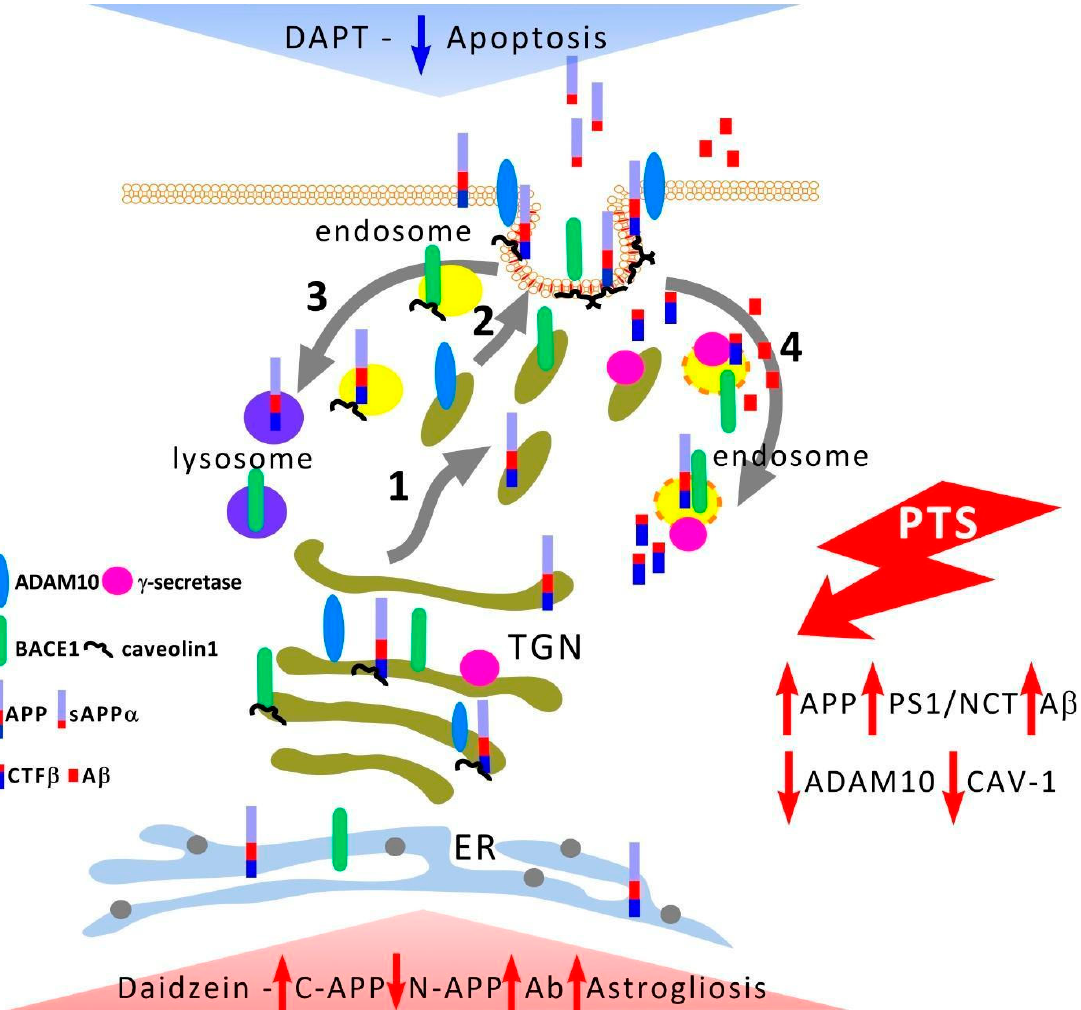
Figure 9. APP processing and effect of secretase and caveolin-1 inhibitors after PTS. Newly synthe- sized APP, BACE1, α -, and γ -secretases (1) are transported to the plasma membrane (2). Caveolae provide a platform for the regulation of APP processing. APP physically interacts with caveolin-1, providing its high concentration on the cytoplasmic membrane. APP is cleaved at the plasma mem- brane by α -secretase releasing sAPP α . After APP is cleaved by α -secretase, sAPP α is released into the extracellular space in a soluble form, while CTF α remains bound to the membrane where it is cleaved in lysosomes or further cleaved by γ -secretase. Most of APP, BACE1, and γ -secretase are internalized into early endosomes from the cell surface back into the cell and degraded in lysosomes (3). Delivery of APP or reduction of its internalization from the cell surface by binding to caveolin- 1 promotes non-amyloidogenic APP processing. Amyloidogenic processing begins with the inter- nalization of APP to endosomes. β -secretase, located on the endosomal membrane, cleaves APP at low pH into two forms in the lipid bilayer: the soluble fragment of APP (sAPP β ) and the membrane- bound β -carboxyl terminal fragment (CTF β ) (4). Further cleavage of CTF β by γ -secretase produces A β monomers and the APP intracellular domain (AICD). The fate of APP along the amyloidogenic or non-amyloidogenic pathway largely depends on the co-localization of APP and secretases that can be influenced by caveolin-1, PTS causes an increase in the level of C- and N-terminal fragments of APP, proteins of the γ -secretase complex of presenilin-1 (PS1) and nicastrin (NCT) and A β with a decrease in the expression of ADAM10 and caveolin-1 (CAV-1). Decreased expression of caveolin1 by administering its inhibitor daidzein shifts APP processing towards A β synthesis that leads to hyperactivation of astrocytes. The administration of the γ -secretase inhibitor DAPT reduces the amount of PTS damage by reducing the level of apoptotic cell death in the peri-infarction area.